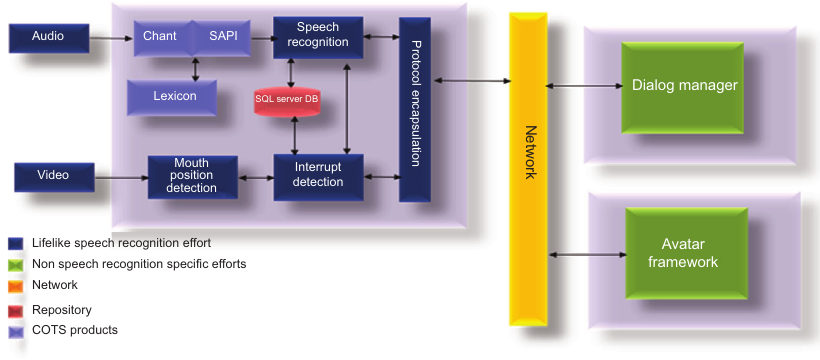
Figure 26. LifeLike Speech Recognition